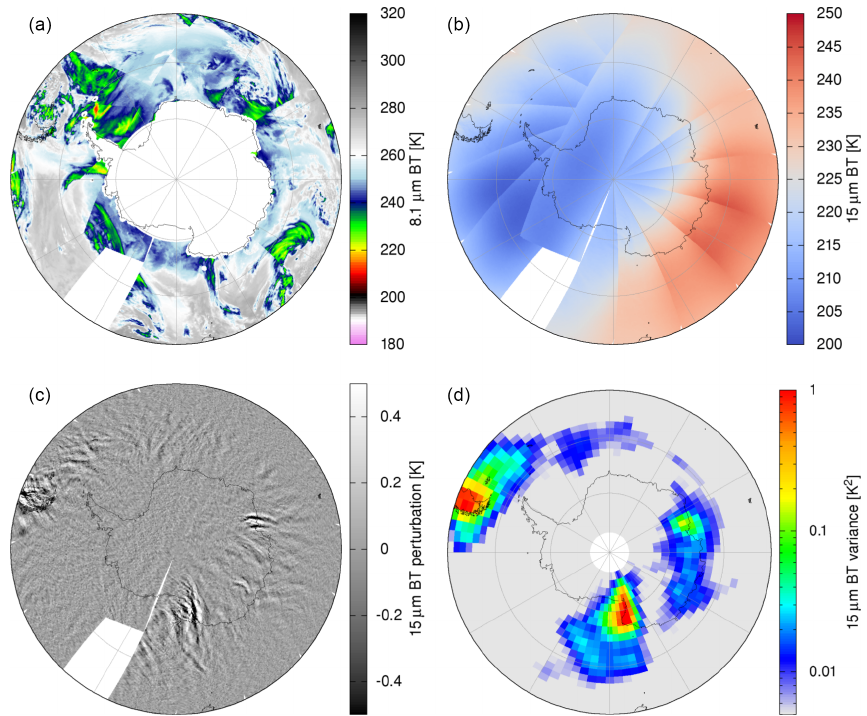
Figure 4. AIRS measurements of 8.1µm (top left) and 15µm (top right) brightness temperatures (BTs) on 24 August 2004 from 12:00 to 24:00UTC. The 8.1µm BT observations show high clouds and storm systems. The 15µm BT perturbation map (bottom left) provides information on gravity waves in the lower stratosphere. BT variances on a 4 ◦ × 2 ◦ longitude–latitude grid (bottom right) are calculated by combining measurements from 00:00 to 12:00UTC (not shown) and from 12:00 to 24:00UTC on the given day to close data gaps and to homogenize temporal